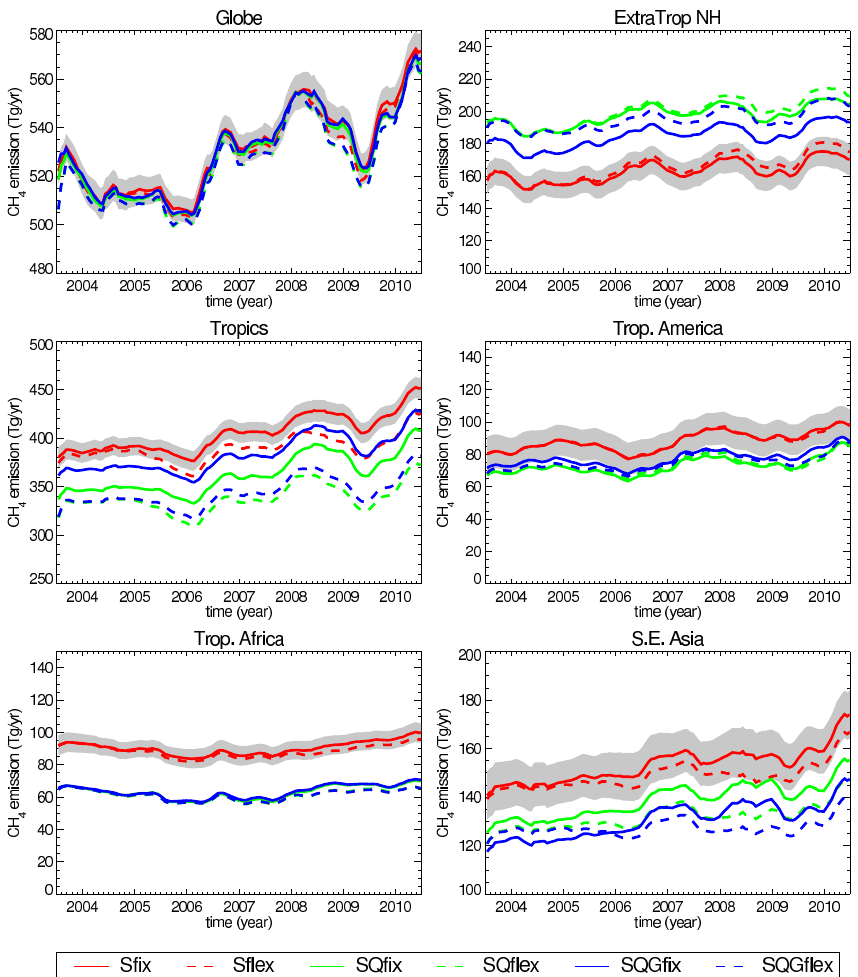
Fig. 11. As Fig. 10 comparing fluxes derived using different SCIAMACHY bias corrections. Solid lines: “fix” scenarios; dashed lines: “flex” Fig. 11. As Figure 10 comparing fl uxes derived using different SCIAMACHY bias corrections. Solid lines: ’Fix’ Scenarios, Dashed lines: scenarios. Red: S ; green: SQ; blue: ’Flex’ scenarios. Red: S, Green: SQ, Blue: SQG.